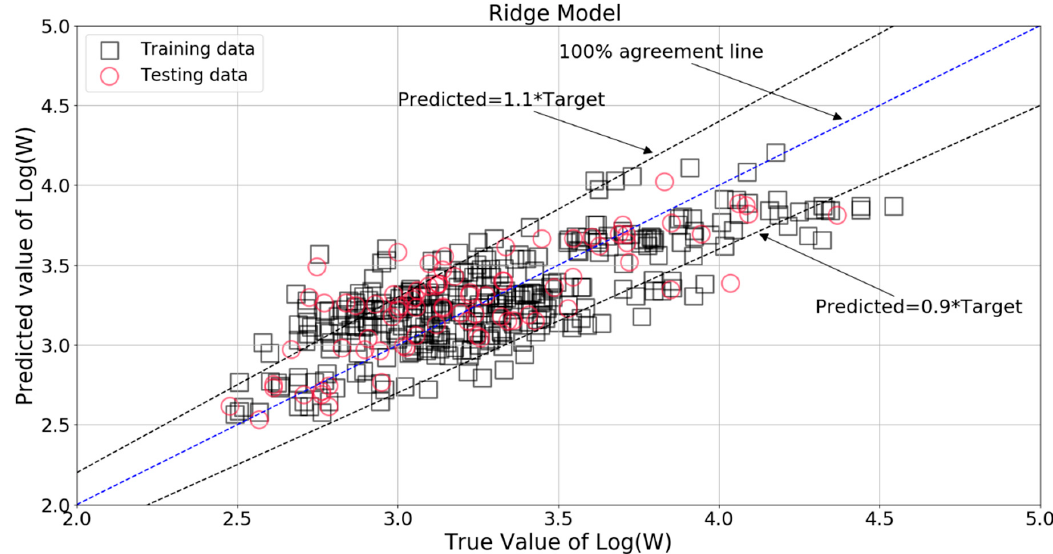
Figure 9. Comparison between the target and Ridge model predicted Log(W).